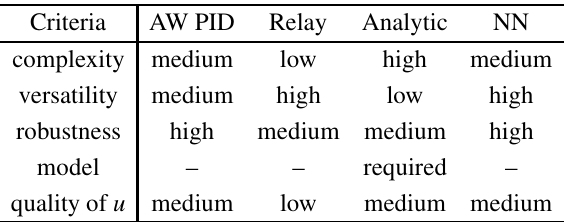
Table 5. Brief overview of the control methods.